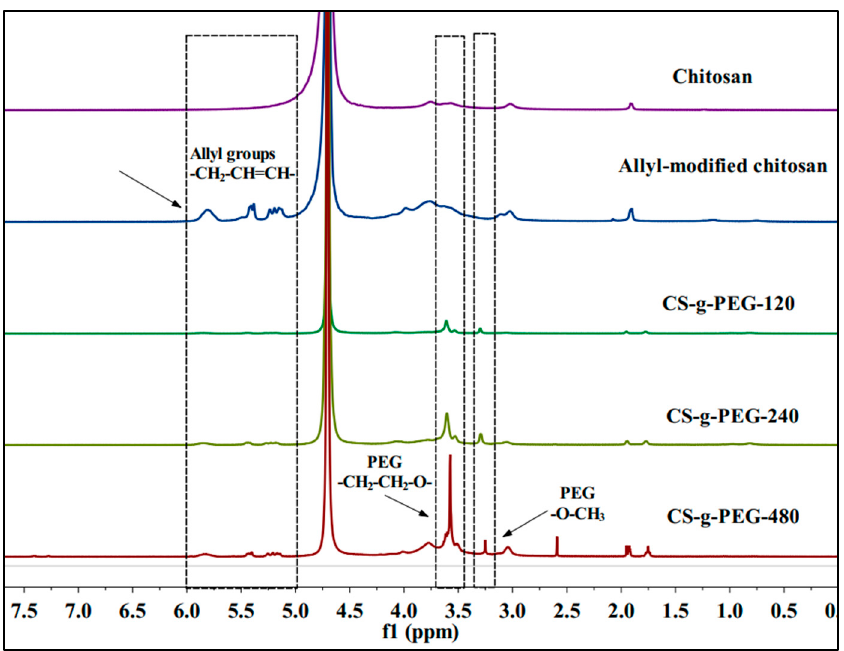
Figure 2. 1 H-NMR spectra of chitosan, allyl-chitosan and CS-g-PEG 120, 240 and 480 in 2% acetic acid-d 4 solution that was prepared using deuteroxide at 400 MHz.